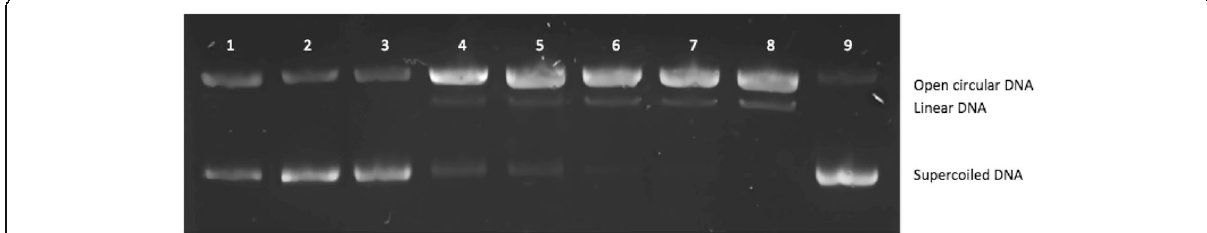
Fig. 1 Peroxyl radical induced DNA scission gels in the presence of Medina and Hasawi mint samples. Lane 1: Hasawi mint soluble extract (0.048 g/mL); Lane 2: Medina mint soluble extract (0.035 g/mL); Lane 3: Medina mint soluble extract, not dechlorophyllized (0.035 g/mL); Lane 4: Medina mint bound extract (2.67 g/mL); Lane 5: Hasawi mint bound extract (2.68 g/mL); Lane 6: Hasawi mint aqueous infusion (0.013 g/mL); Lane 7: Medina mint aqueous infusion (0.013 g/mL); Lane 8: Blank (DNA and AAPH only); and Lane 9: Control (DNA